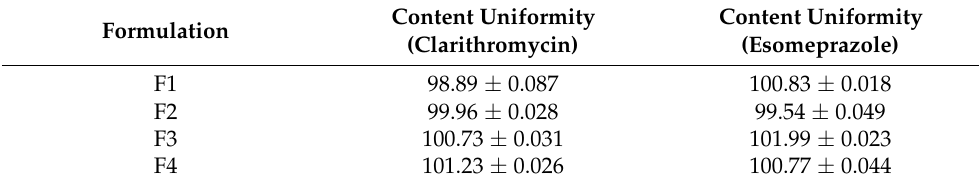
Table 5. Content uniformity of Clarithromycin and